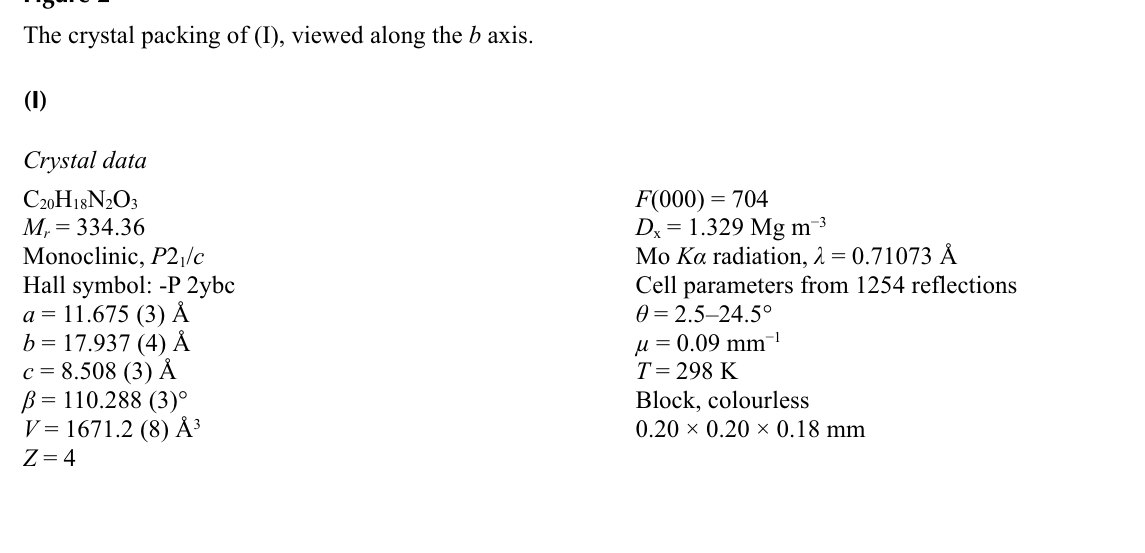
The crystal packing of (I), viewed along the b